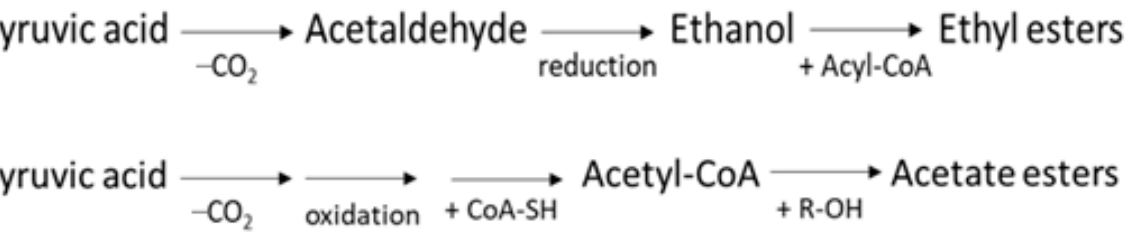
Figure 7. Scheme of the biosynthetic pathway which leads to the formation of ethyl and acetate esters, starting from pyruvic acid